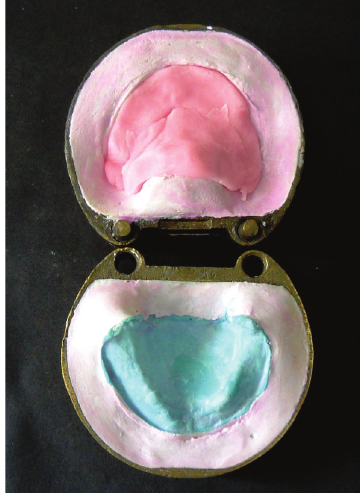
Figure 7: Dewaxing of the tongue prosthesis.